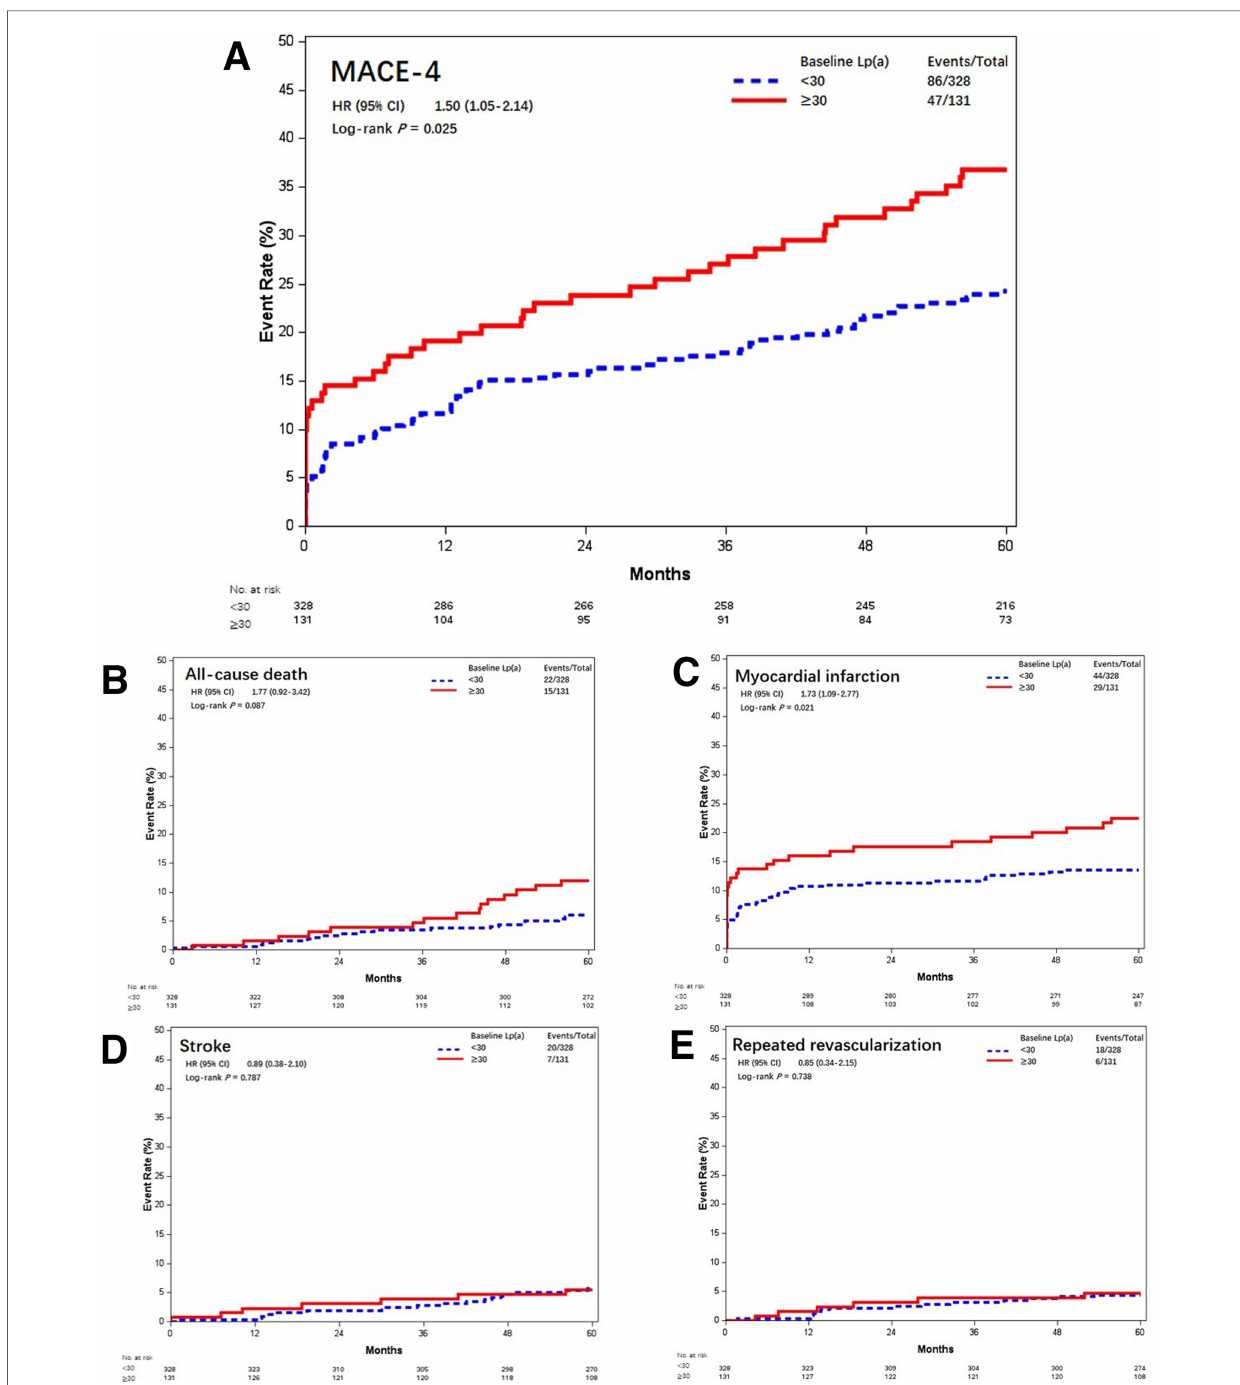
FIGURE 5 Kaplan – Meier curves of MACE-4 and each individual component different baseline Lp(a) levels (mmol/L). Kaplan – Meier estimates for freedom from ( A ) MACE-4, ( B ) all-cause death, ( C ) myocardial infarction, ( D ) stroke, and ( E ) repeated revascularization. Lp(a), lipoprotein(a); MACE-4, 4-point major adverse cardiovascular